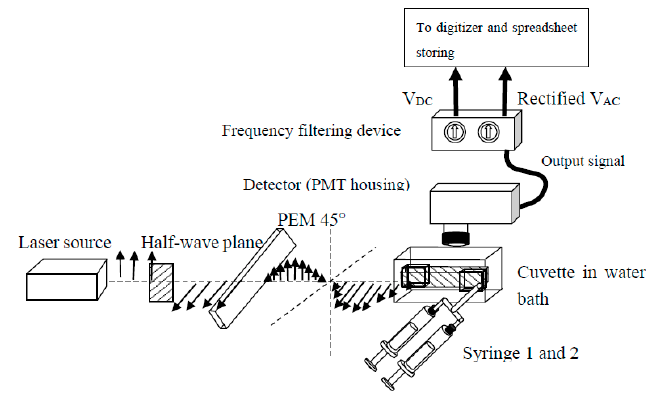
Figure 2. The modular dual-channel Stopped-Flow apparatus is equipped with a frequency rejection circuit for anisotropy, r(t) , and fluorescence, F(t) , detection. The optical train consists of the Coherent Ar + ion laser (Innova 70-4 Argon, Santa Clara, CA, USA) source, a half-wave plate, the PEM at 45 ° of the vertical electric vector, and the detector placed in an L-type configuration. The half-wave plate changes by 90° laser excitation plane just before being modulated by the PEM. The detector housing can accommodate interchangeable interference filters (e.g., 520 nm, 580 nm, and 620 nm) to collect the fluorescence emission of the diverse dyes. The fluorescence emission is split into two signals, V DC (t) and rectified V AC (t) , by the electronic filters to be later digitized and stored in spreadsheets to yield r(t) and F(t) according to Equation (7) and Equation (8), respectively. The temperature of the cuvette and syringes is controlled by a water bath from 10 °C to 30 °C. The syringes are simultaneously pushed by an air-controlled piston to deliver 150 μ L solution each to be ball mixed with a 1 ms death time.